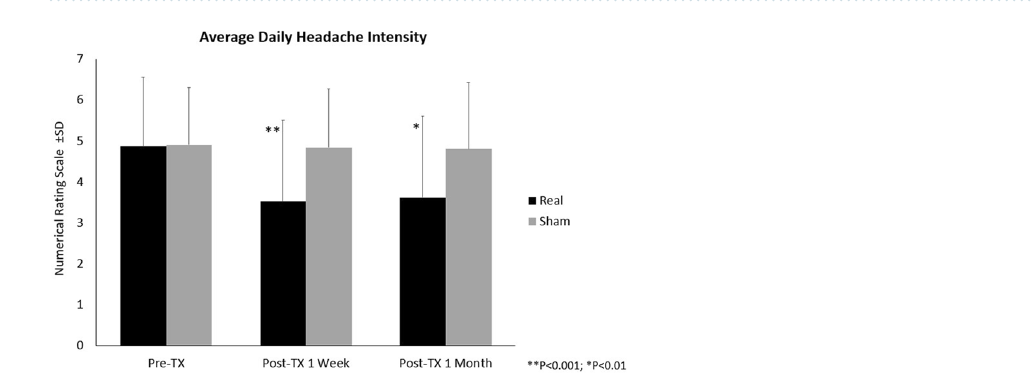
Table 4. Table of means (± SD) of headache assessments and significant findings. Post-TX: post-treatment. The bold values represent significance of p < 0.05